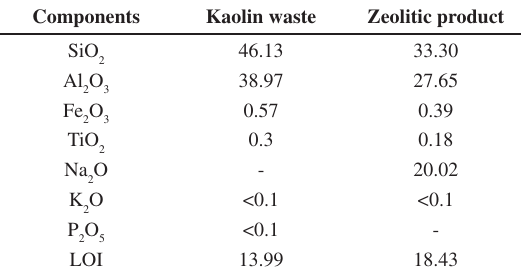
Table 1. Chemical analysis of kaolin waste and zeolitic